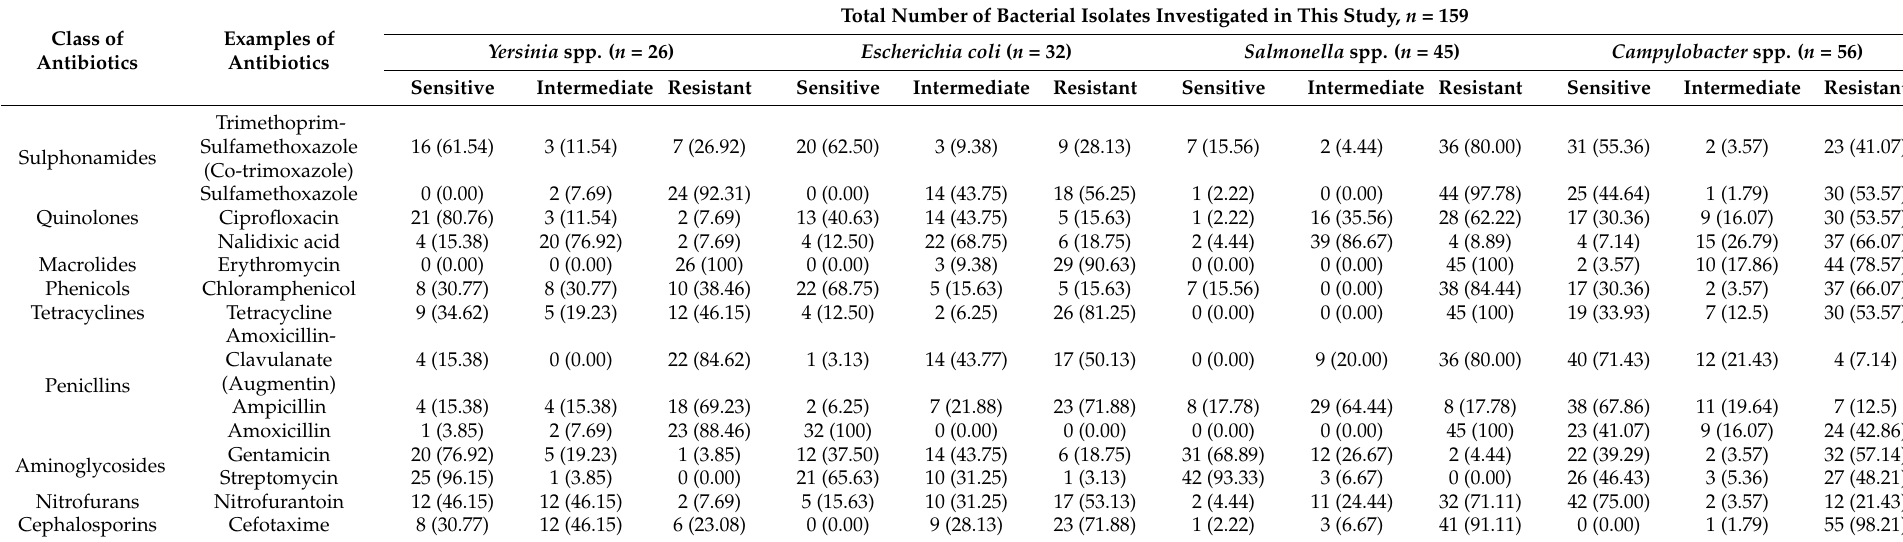
Table 1. Frequency of antibiotics’ susceptibility patterns among the bacterial isolates in this